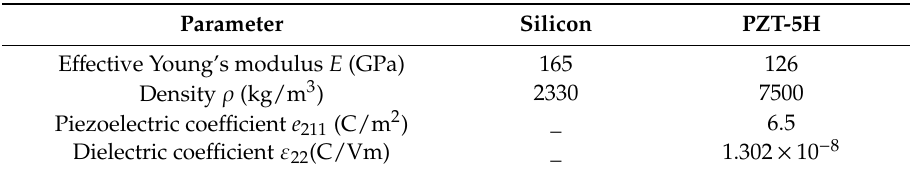
Table 1. Material properties of the MEMS-based harvester.